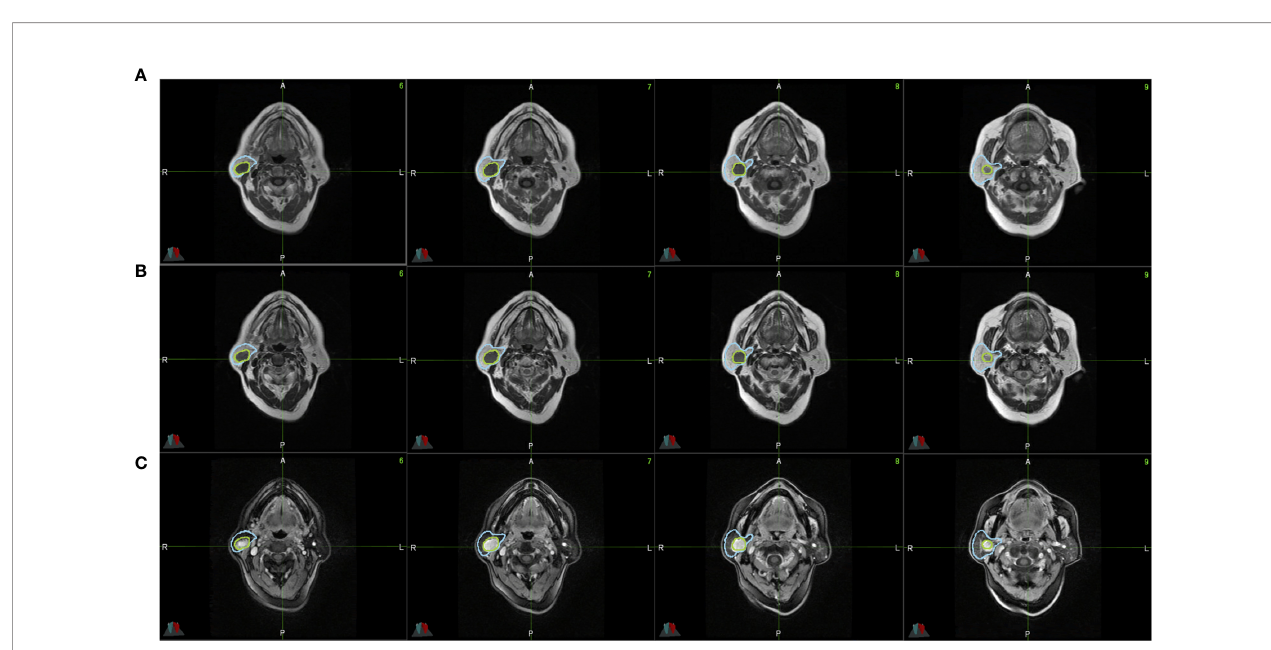
FIGURE 2 | All parotid gland and tumor ROIs from a single patient ’ s lesion on MR images. (A) shows T1-weighted MR images. (B) shows CE-T1-weighted MR images. (C) shows T2-weighted MR images. The blue region is the parotid gland, and the green region is the